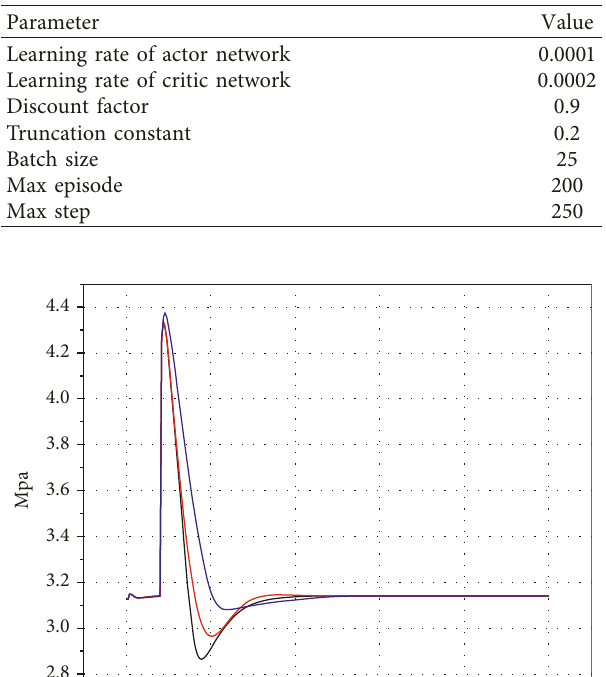
Table 2: Settings of hyperparameter for PPO algorithm.